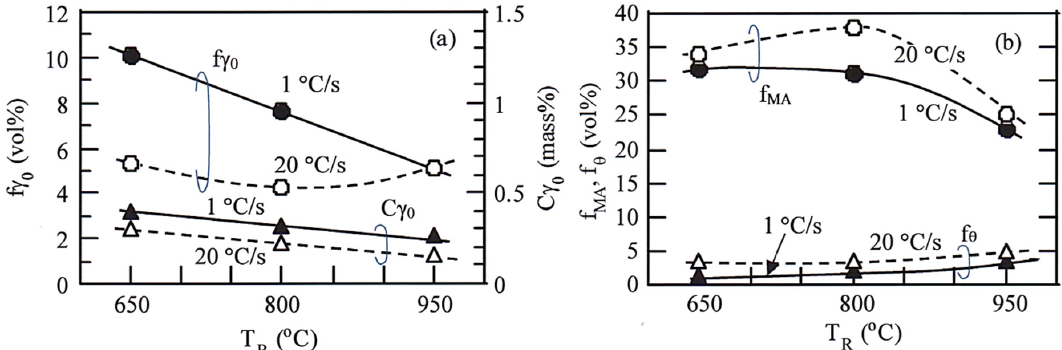
Figure 18. Variations in ( a ) initial volume fraction (f γ 0 ) and initial carbon concentration ( C γ 0 ) and ( b ) volume fractions of MA phase ( f MA ) and carbide ( f θ ) of retained austenite as a function of warm working temperature ( T R ) in 0.23%C–1.5%Si– 1.5%Mn–1.0%Cr–0.2%Mo–0.1%Ti–0.0019%B TM steel [82]. Cooling rate: 1 ° C/s (solid marks) or 20 ° C/s (open marks). Reduction strain: 40%. Reprinted with permission from AIST: Iron Steel Technol., Copyright 2021.